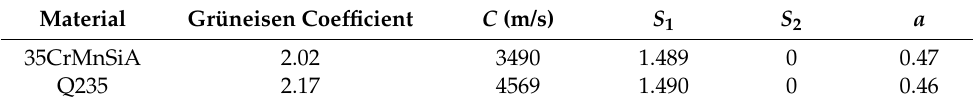
Table 3. Parameters of Grüneisen equation of state 35CrMnSiA and Q235.